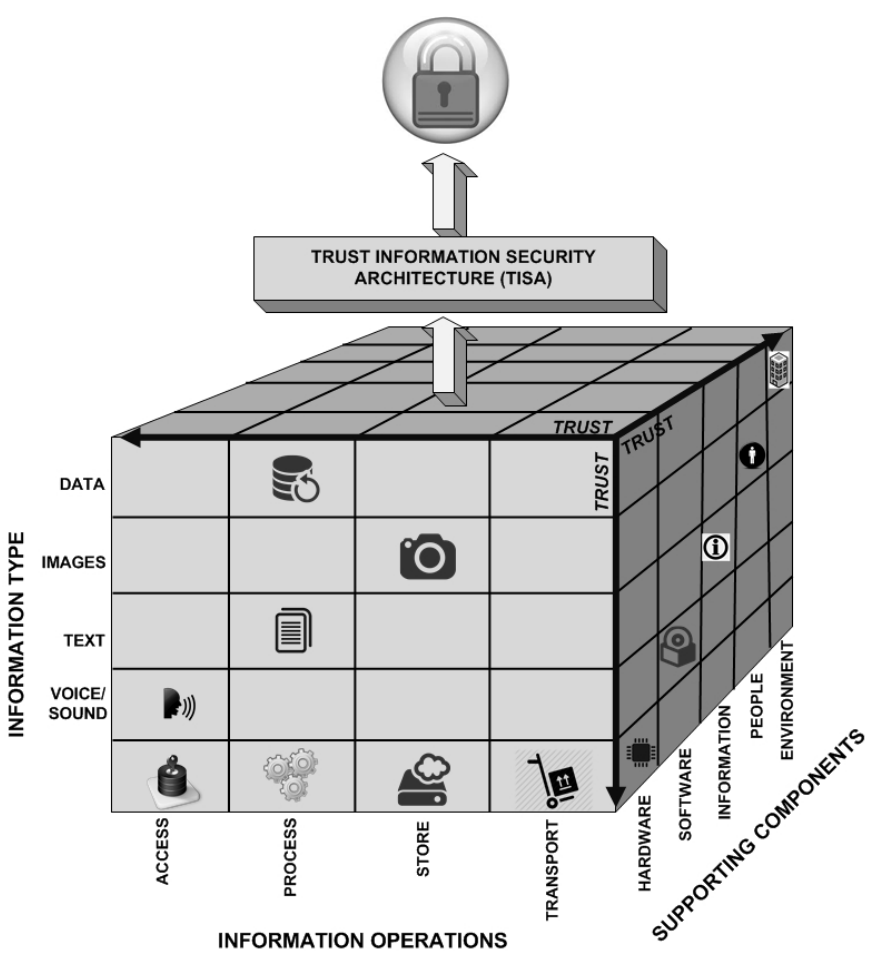
Figure 5. Types of information, operations and